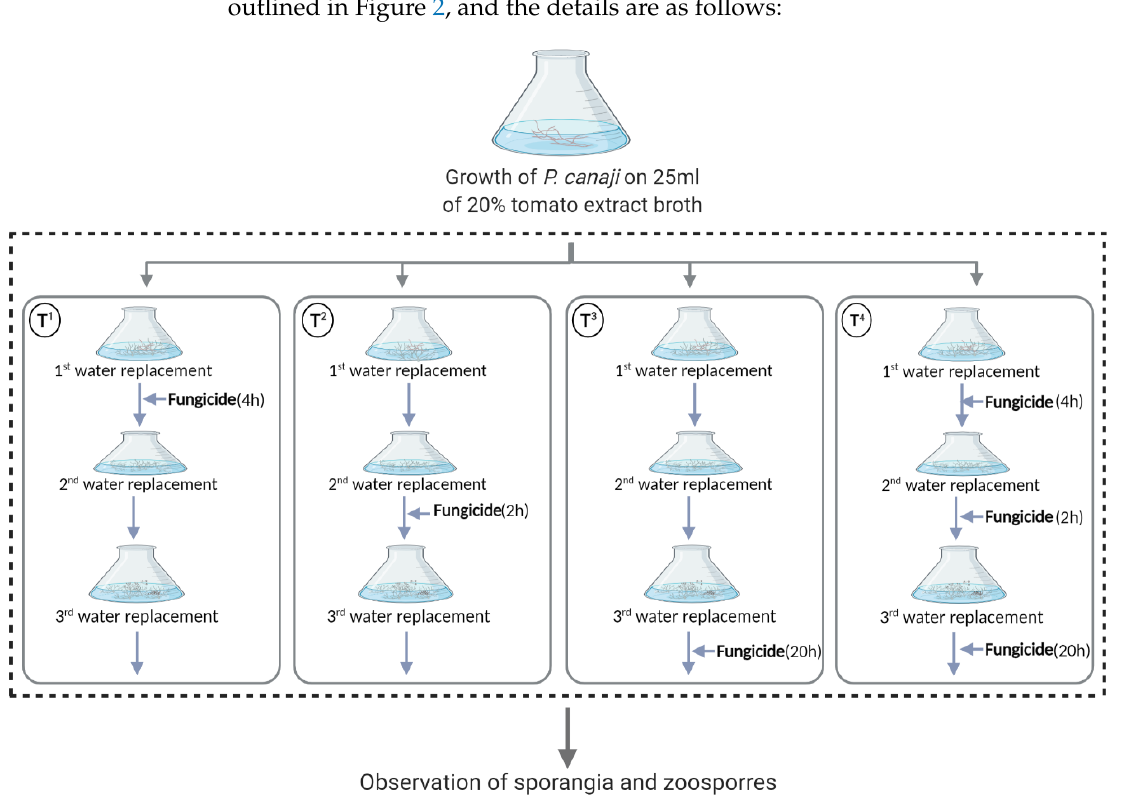
Figure 2. Schematic illustration of the time of fungicide applications to the media for P. cajani sporangia and zoospore induction. T 1 —fungicide added during 1st water replacement